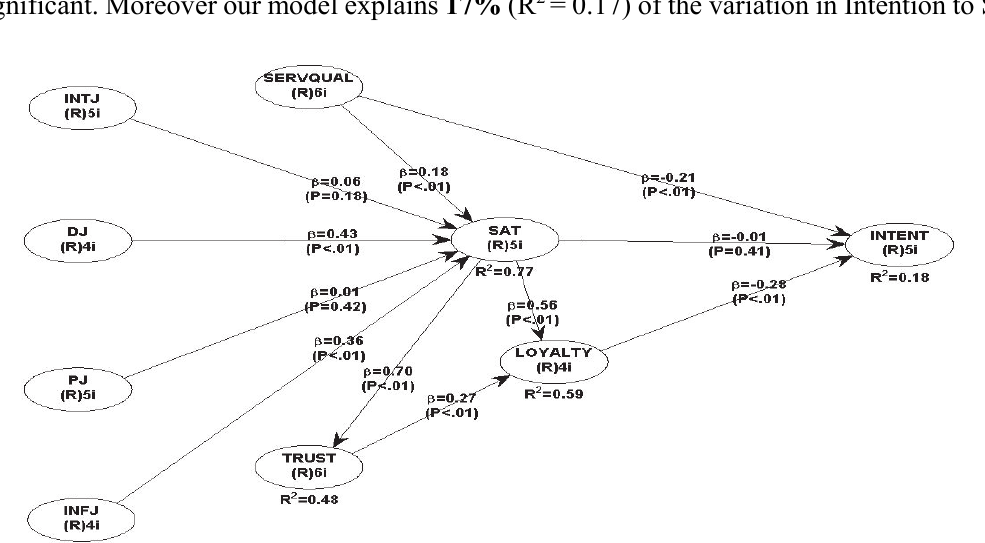
Fig. 2 . Structural Evaluation Model showing Path Coefficient and R